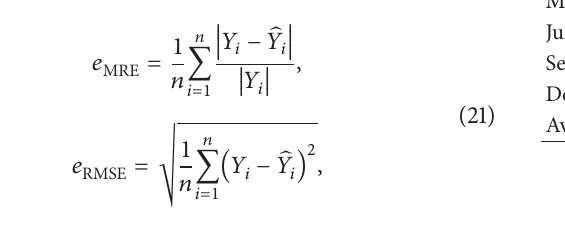
For evaluating the forecasting performance, mean relative error (MRE) and root mean square error (RMSE) are used;